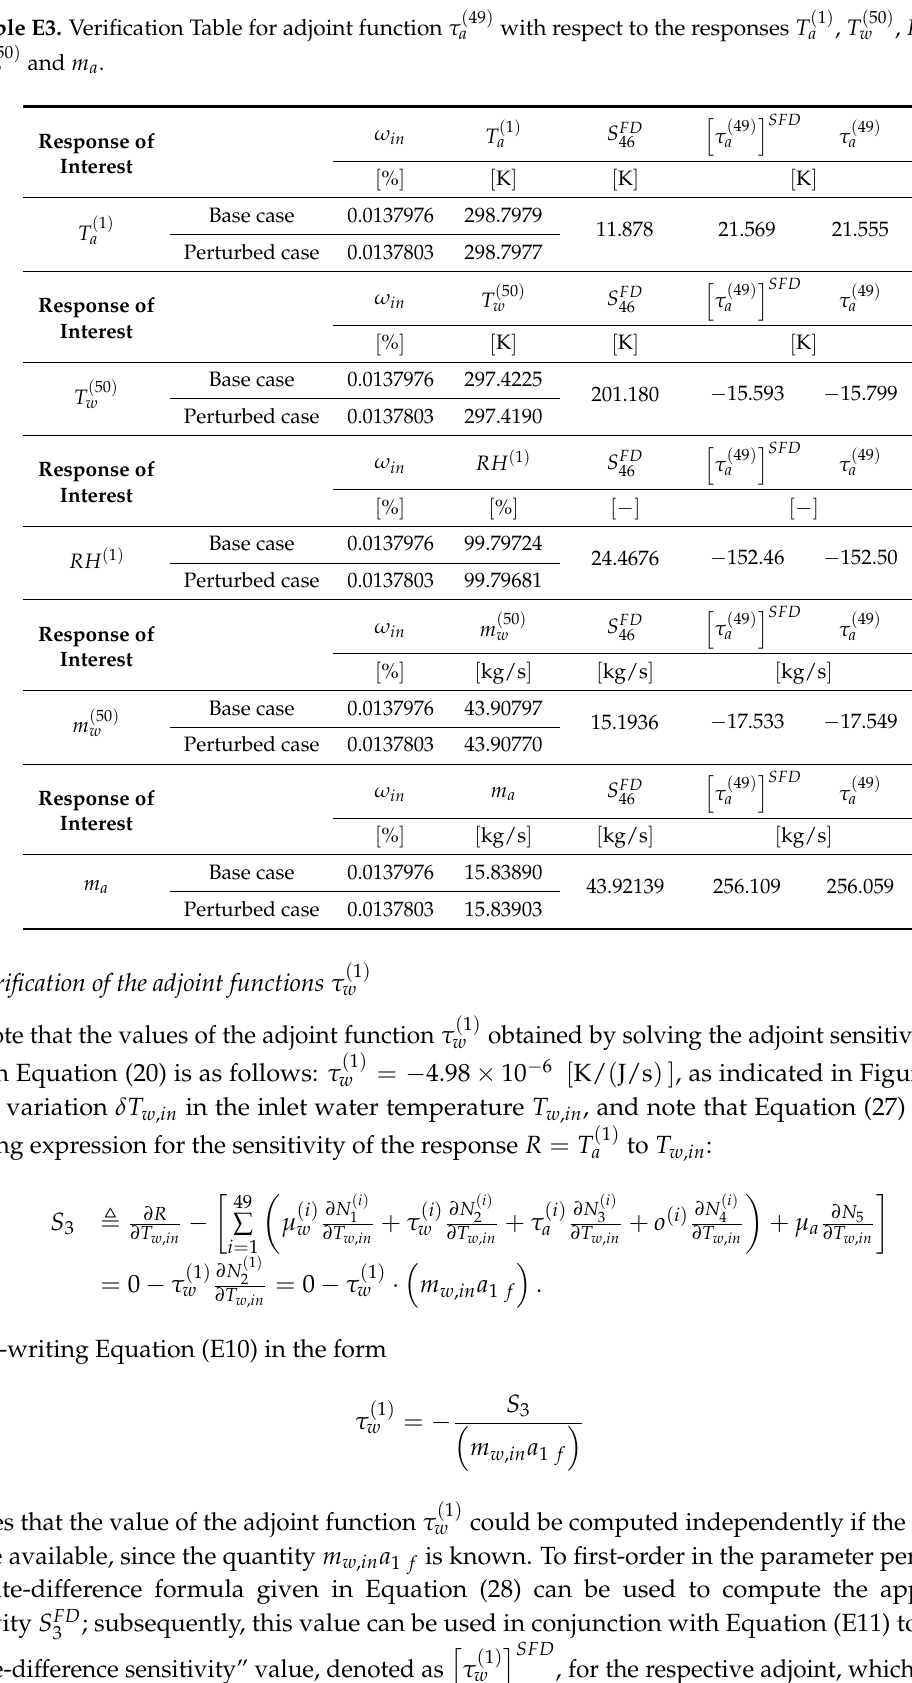
( 49 ) a with respect to the responses T